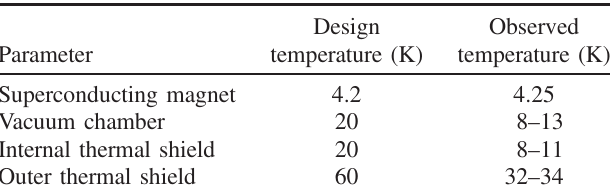
TABLE V. SCU1 design and observed temperatures.